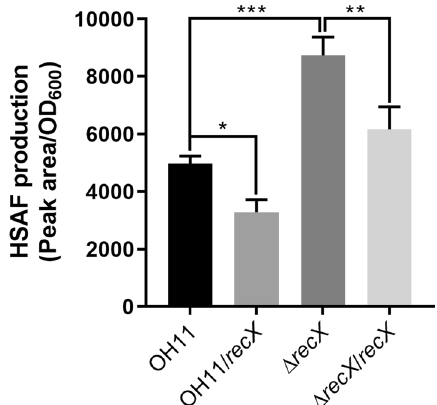
Fig. 4 Quantification of HSAF produced by the Lysobacter enzymogenes ∆ recX mutant. Error bars, mean (n